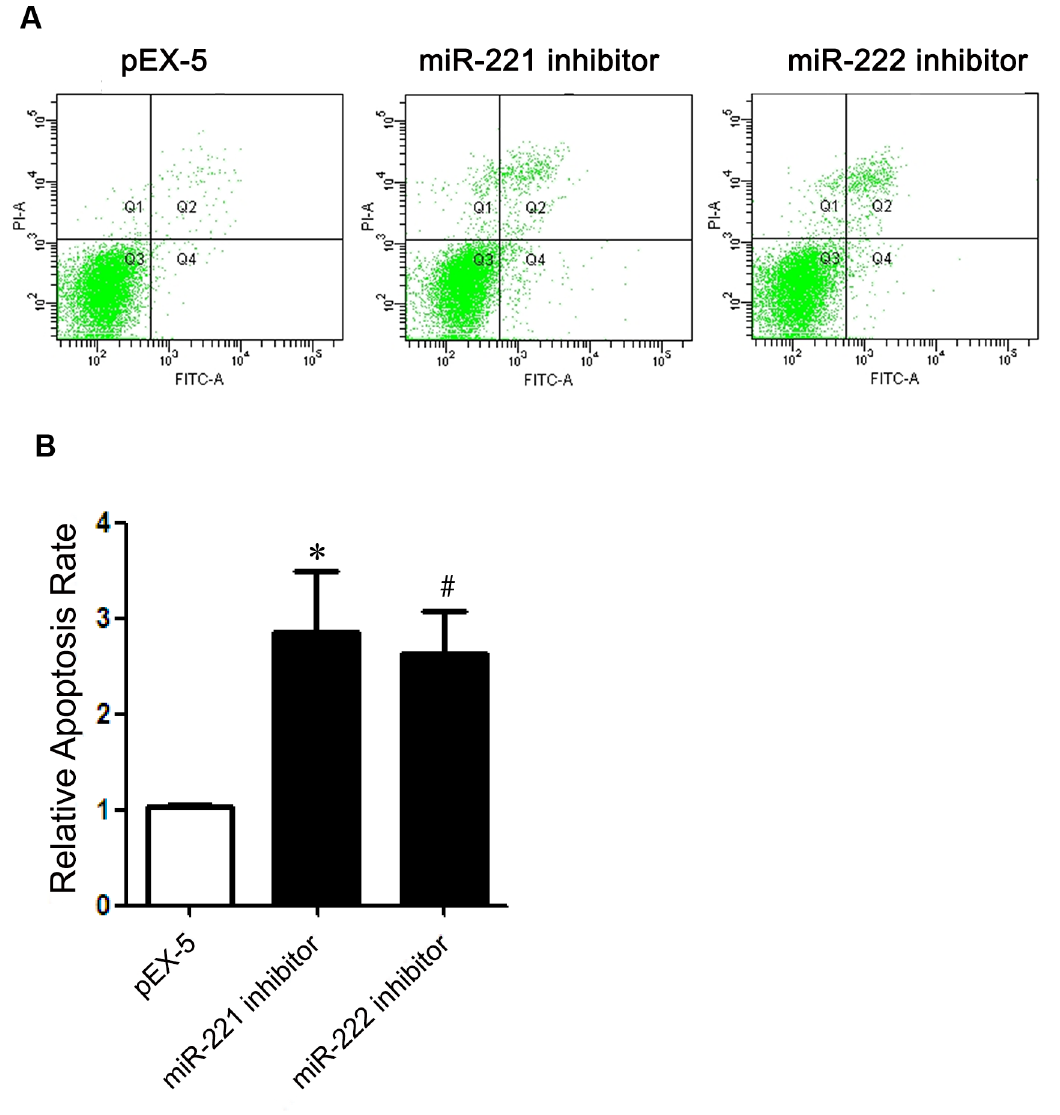
Figure 4. Effects of miR-221 inhibitor and miR-222 inhibitor on apoptosis. ( A ) Apoptotic cell distribution of PC-3 cells transfected with pEX- 5 miR-221 inhibitor or miR-222 inhibitor by flow cytometry. ( B ) Relative apoptosis rate of each group. Data represent the mean value 6 SEM from three separate experiments.( *, # P , 0.05 vs pEX-5.